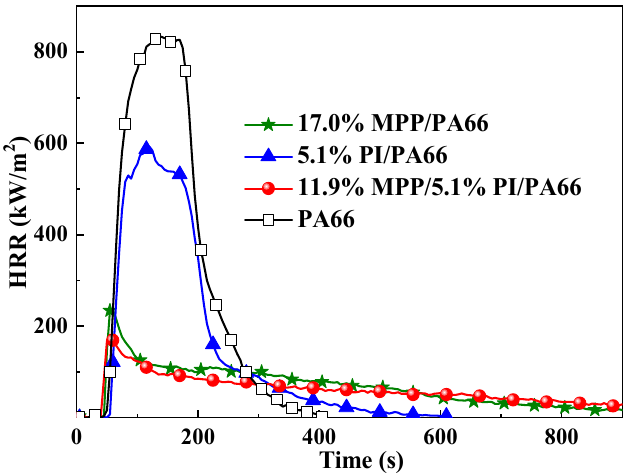
Figure 2. The HRR curves of the flame-retardant PA66 composites.